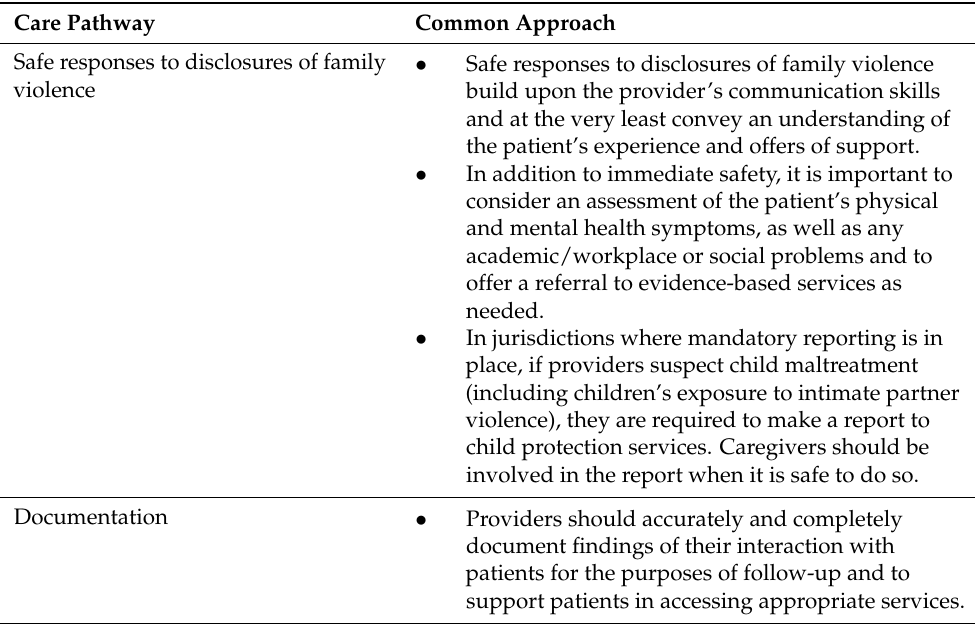
Table 1. Cont. Care Pathway Common